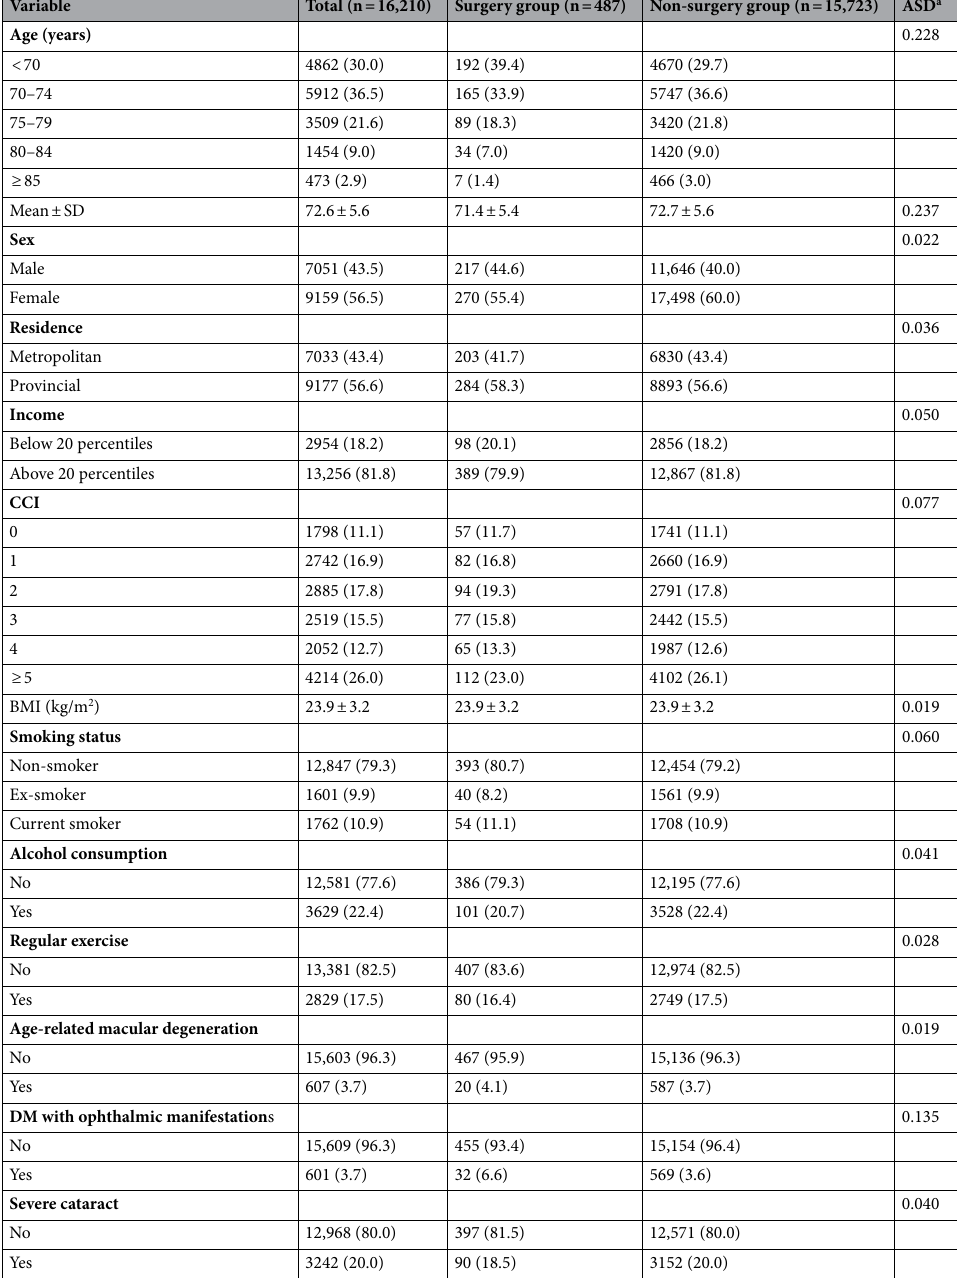
Table 1. Baseline characteristics of patients according to history of glaucoma surgery. BMI body mass index, CCI Charlson Comorbidity Index, DM diabetes mellitus, ASD absolute standardized difference. Data are expressed as mean ± standard deviation (SD) or n (%). a ASD of > 0.1 is considered a meaningful